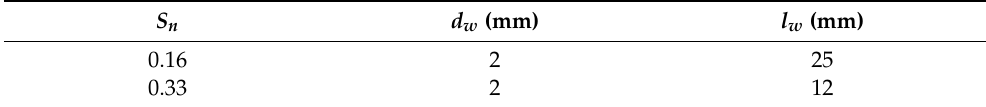
, and d w and l w are the diameter and length of the l w